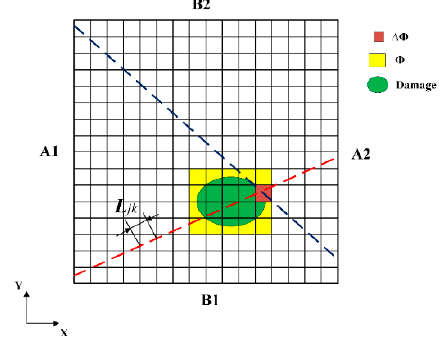
Figure 5. Models of estimated possible damaged area.